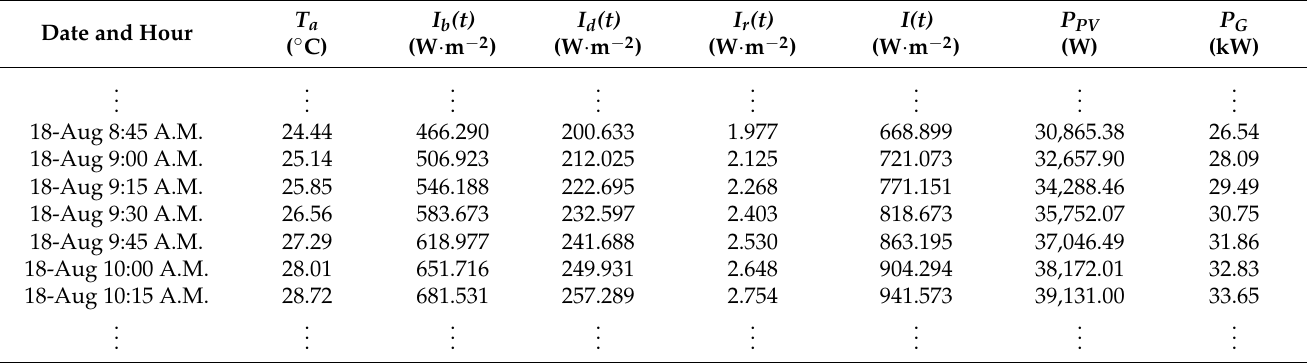
Table 8. Supply matrix for a generator configuration of 20 series panels and 8 strings.